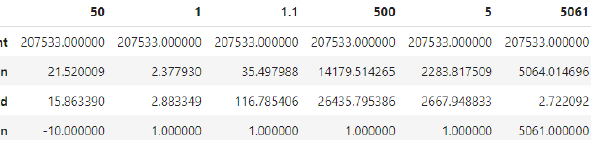
Figure 12. The Standard Deviation and the Mean of the UGRansome1819 Dataset.